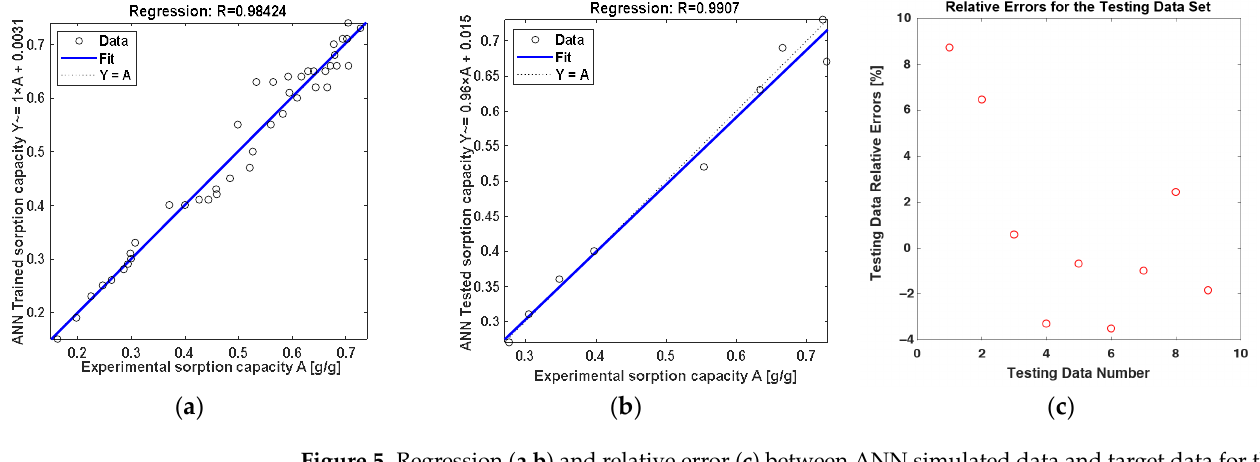
Figure 5 . Regression ( a , b ) and relative error ( c ) between ANN simulated data and target data for the training ( a ) and testing ( b ) subsets, case of ANN sorption model for the 15% contaminated soil .